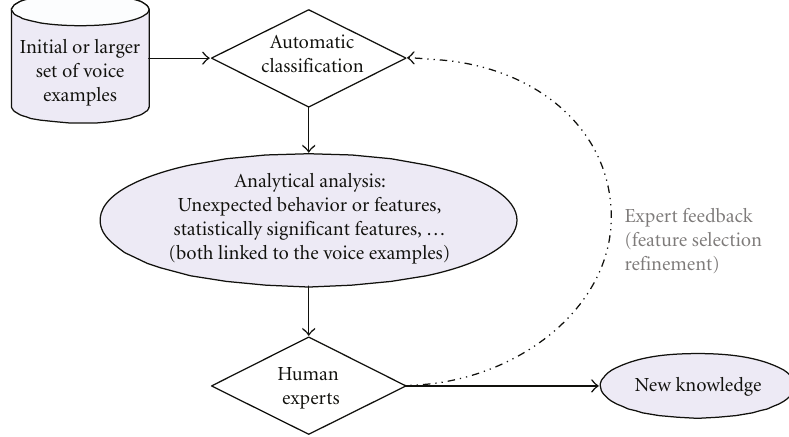
Figure 2: The “automatic system to human experts/knowledge” feedback